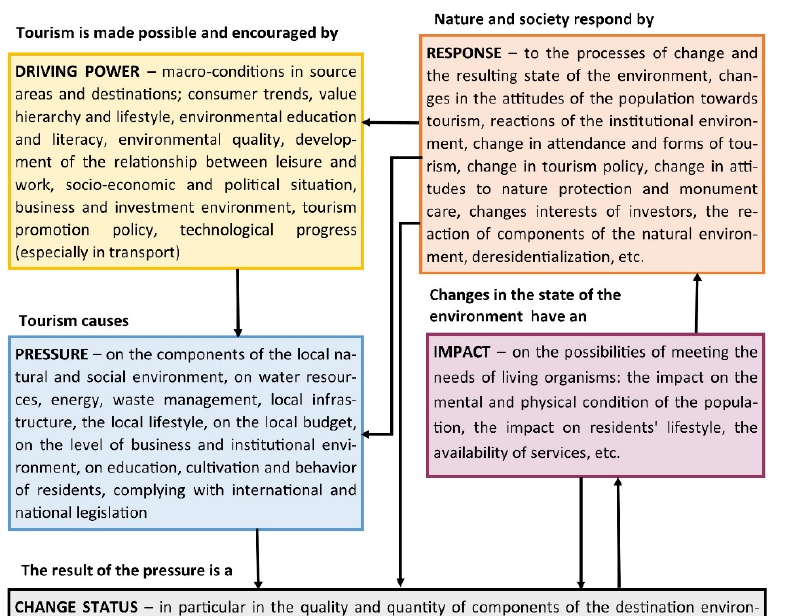
Figure 2. DPSIR model for tourism. Source